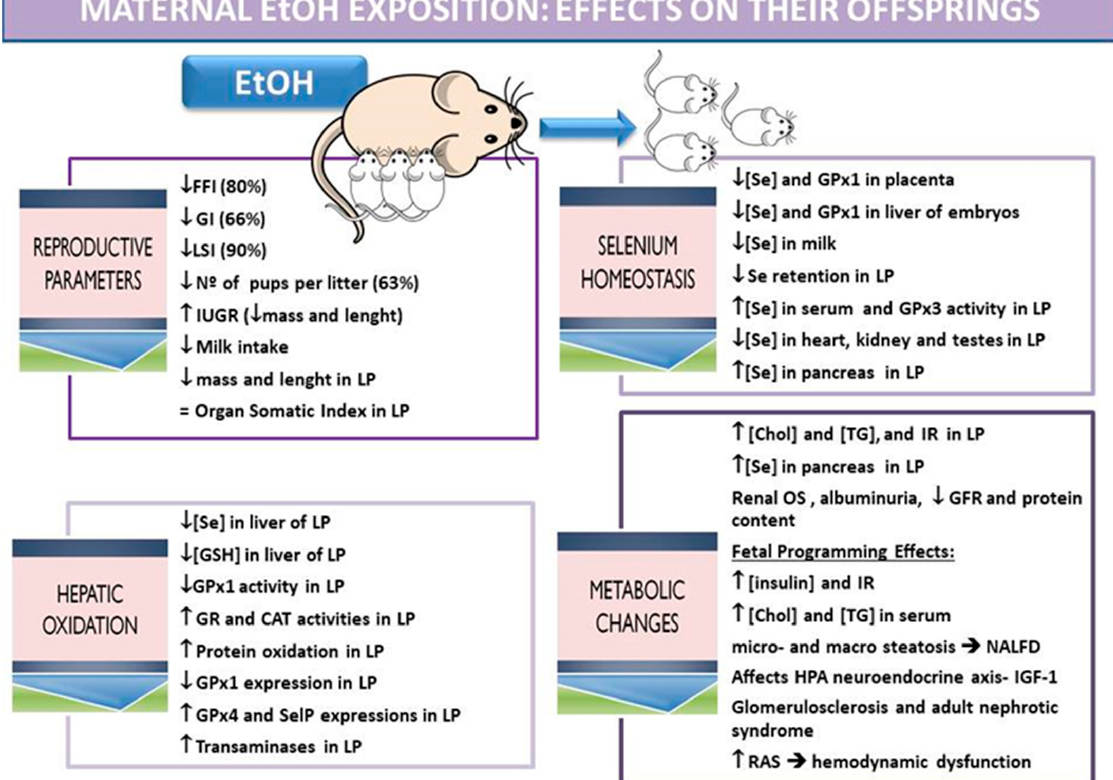
Figure 2. Maternal EtOH exposure: effects on their offspring related to reproductive parameters, selenium homeostasis, hepatic oxidation and metabolic changes. All the results are extracted from a chronic EtOH exposure model applied to mothers during preconception, gestation and lactation periods carried out by this Research Group, except the data included in the metabolic changes section: Fetal Programming Effects. FFI: fertility female index (number of pregnancies/number of mating × 100), GI: gestation index (number of successful births/number of pregnancy rats × 100), LSI: lactation survival index ((number of total offspring—number of died offspring/number of total offspring) × 100), IUGR: intrauterine growth retardation, LP: lactating pups, GSH: glutathione, GPx: glutathione peroxidase, CAT: catalase, GR: glutathione reductase, SelP: selenoprotein P, Chol: cholesterol, TG: triglycerides, OS: oxidative stress, GFR: glomerular filtration rate, IR: insulin resistance, NALFD: non-alcoholic fatty liver disease, HPA: hypothalamic–pituitary–adrenal axis, IGF-1: insulin-like growth factor, RAS: renin-angiotensin system.